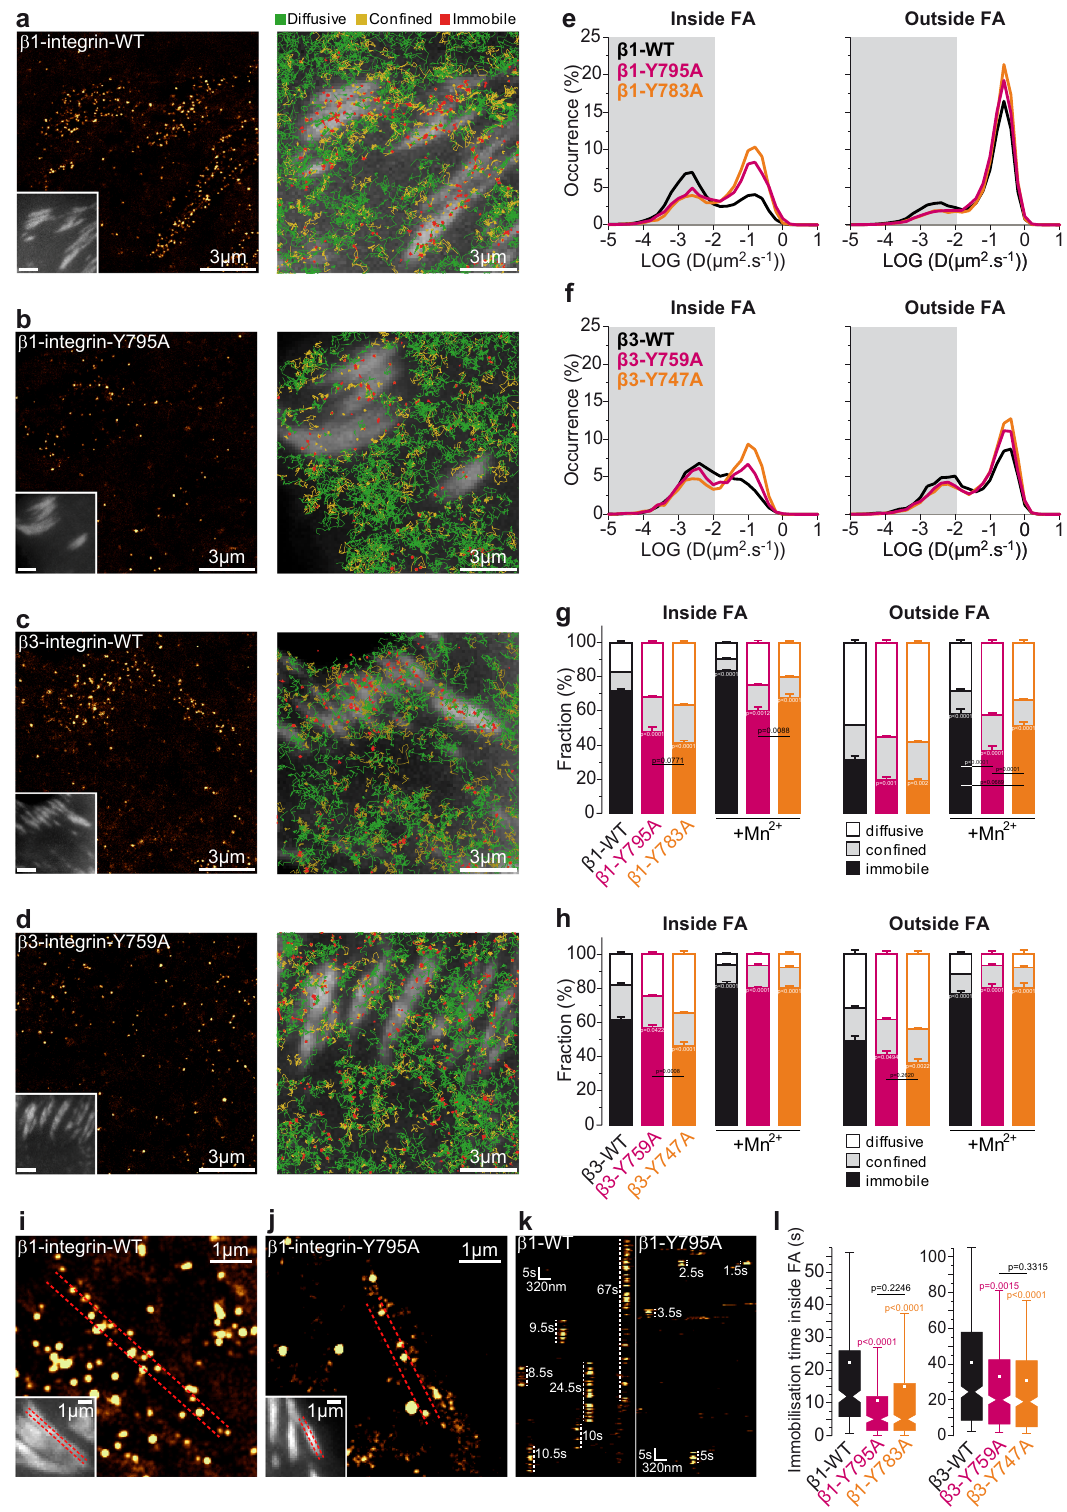
generated super-resolved time-lapses and kymographs (Fig. 1i – k) to compare β -integrin immobilization times and found that immobi- lization durations were longer for β 1-WT-mEos2 and β 3-WT- mEos2 compared to the kindlin-binding defective mutant β 1- Y795A-mEos2 and β 3-Y759A-mEos2 (Fig. 1k, l). Integrin activation by kindlin was shown to be critical for the formation of NAs and membrane protrusions 17,18 . As a consequence, kindlin-de fi cient NATURE COMMUNICATIONS| (2021) 12:3104